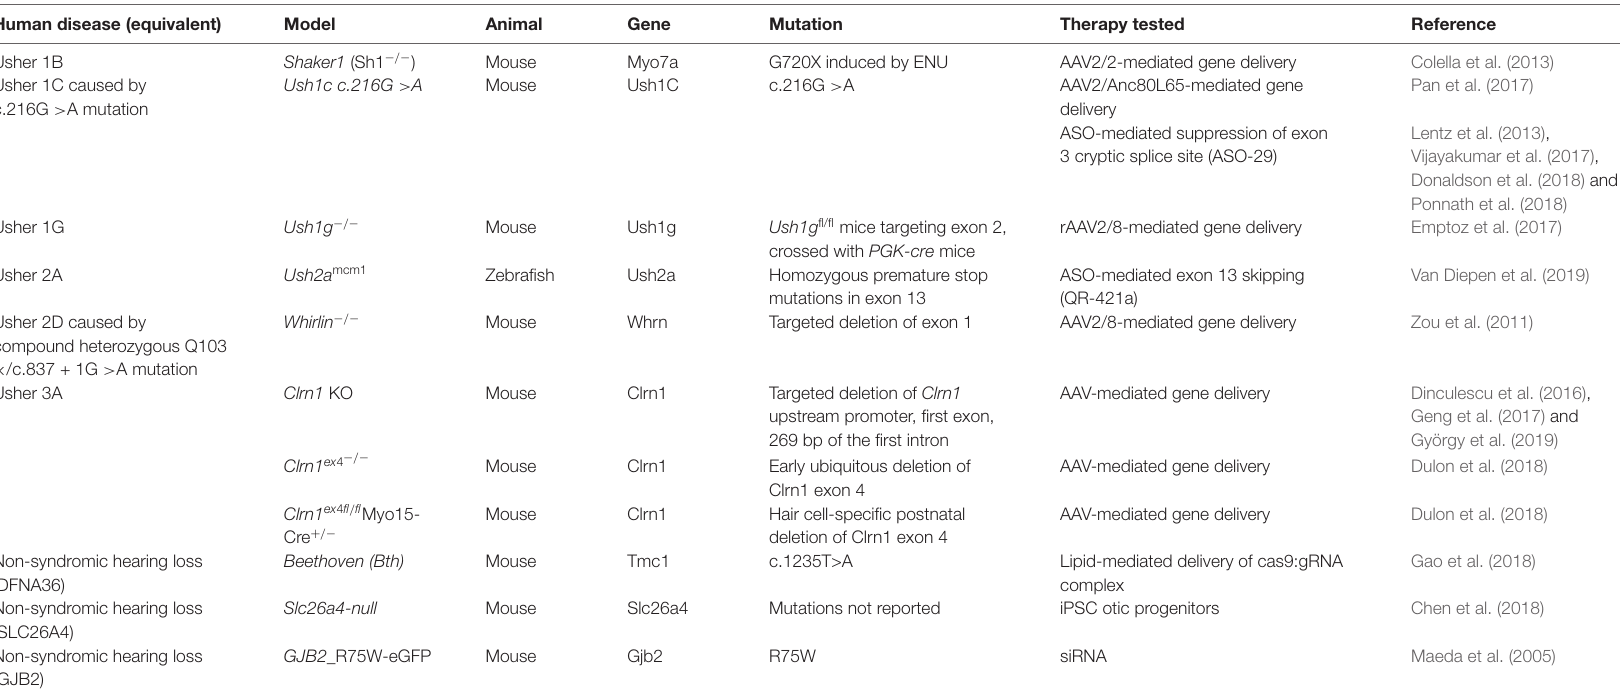
TABLE 3 | Summary of transgenic animal disease models discussed in this